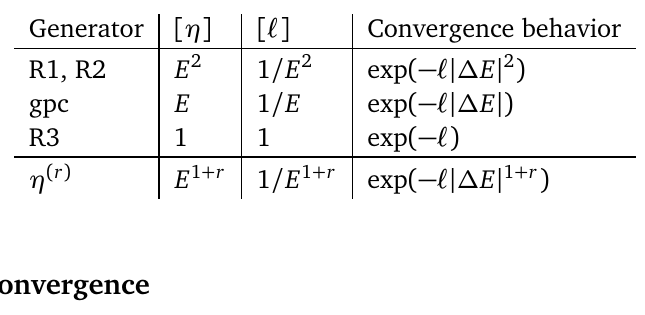
Table 1: Comparison of the dimensions and convergence behaviours of the generators considered in this